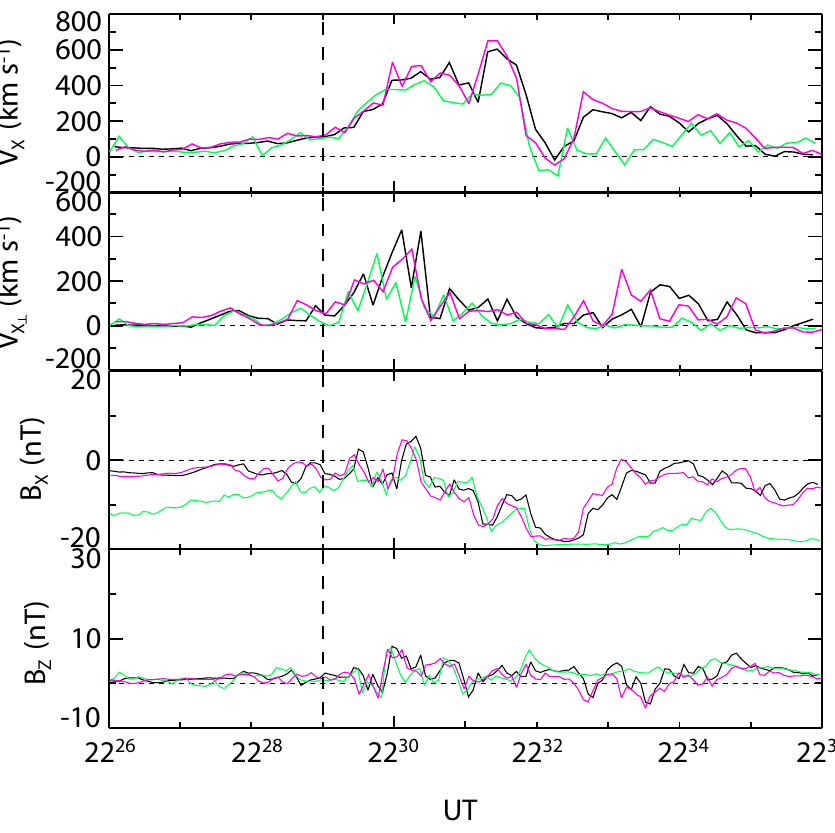
Fig. 3. A summary of Cluster flow and magnetic observations for the interval 22:26–22:36 UT, presented in GSM coordinates. The top panel shows the V x component of the flow and the second panel shows the magnetic field-perpendicular component of this flow. The bottom two panels show the B x and B z components of the magnetic field. These data have been used to estimate an “onset” time for the BBF of 22:29 UT, which is indicated on this and other plots by the vertical dashed